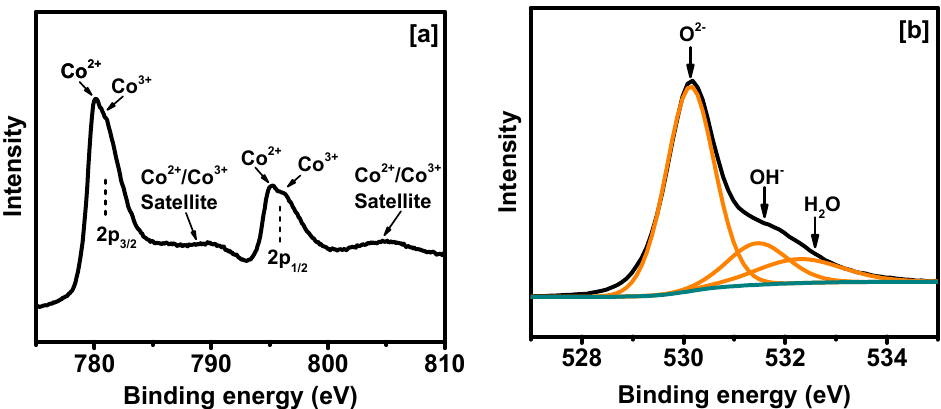
Figure 1. X-ray photoelectron spectroscopy (XPS) core level spectra of ( a ) Co 2p and ( b ) O 1s.